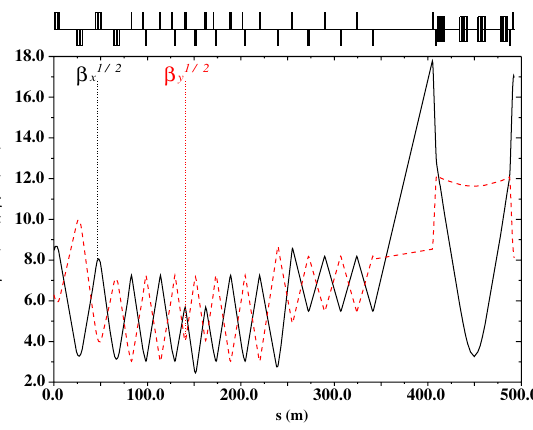
(cid:7) for M as a function of cell phase advances for 4 wire stations and 6 wire stations with XY XY